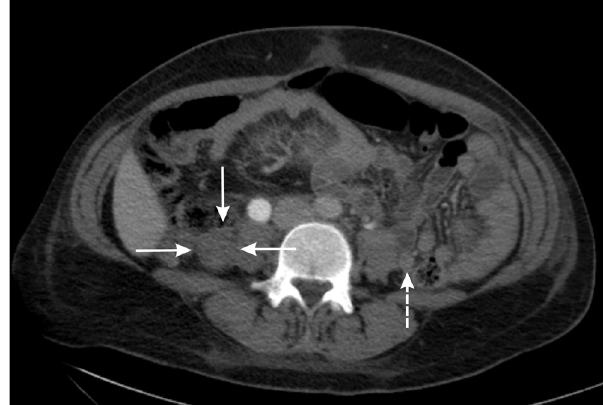
Figure 2 - A computed tomographic image that depicts the patient’s normal left ovarian vein (dashed arrow) and right, enlarged and thrombi-filled, ovar- ian vein (three solid arrows).